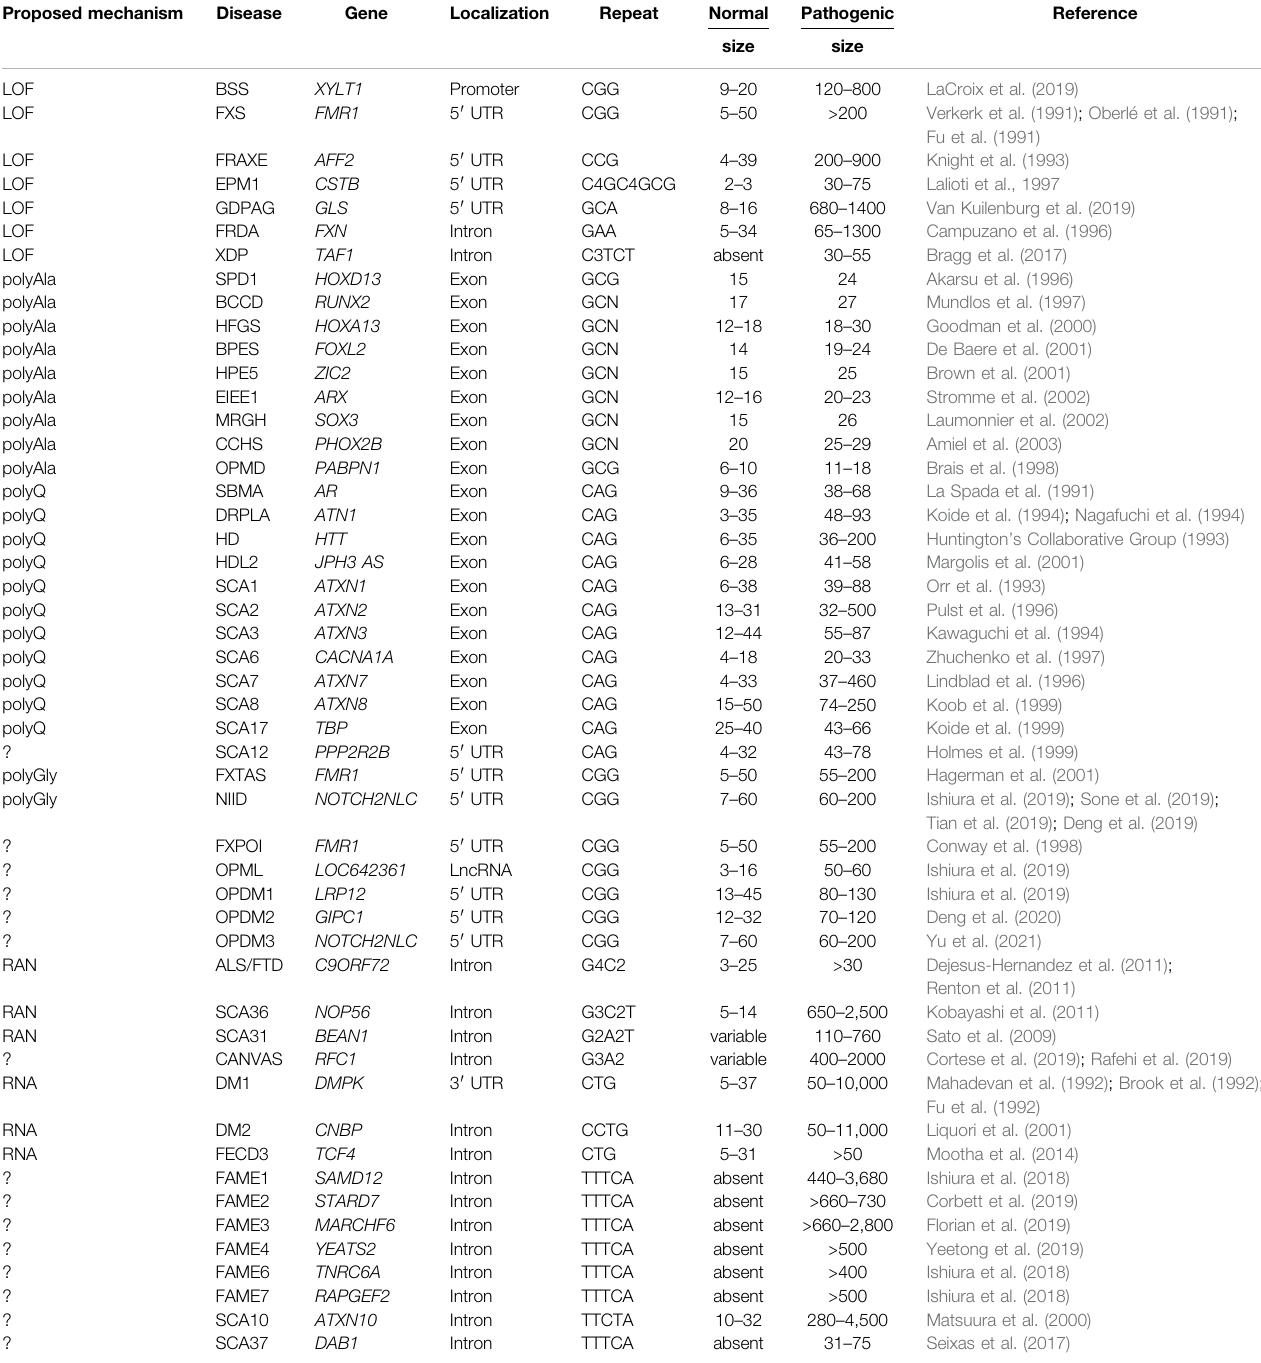
TABLE 1 | Repeat expansion diseases, sorted by their proposed pathogenic